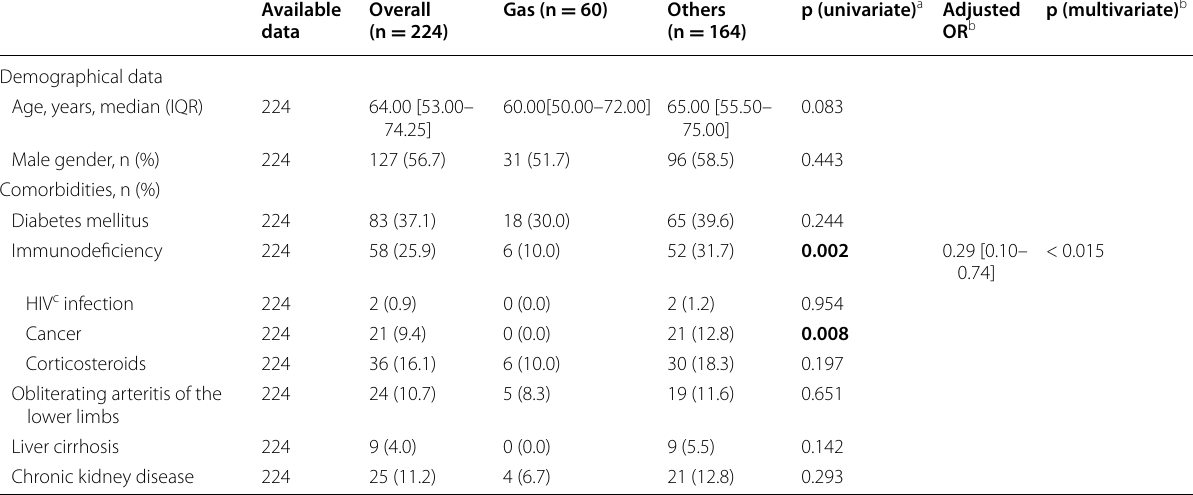
Table 1 Admission characteristics associated with group A streptococcal documentation for 224 patients admitted for necrotizing soft tissue infection Available